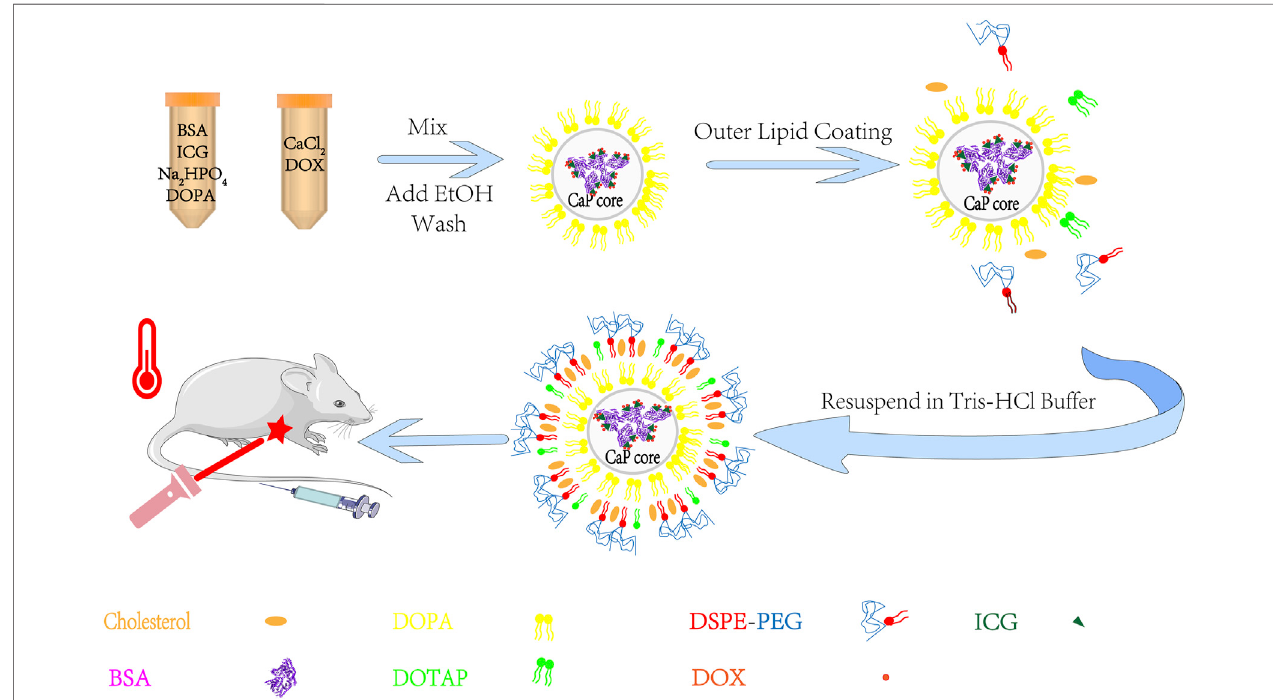
FIGURE 2 | The outline for the preparation of BID-liposomal nanocomposites. The liposomal nanocomposites were prepared by combination of a water-in-oil microemulsion method and a fi lm-dispersion method. BSA/ICG/DOX aggregates were concentrated in the core of liposomal nanocomposites for improvement of stability and synergistic chemo-photo-thermal antitumor